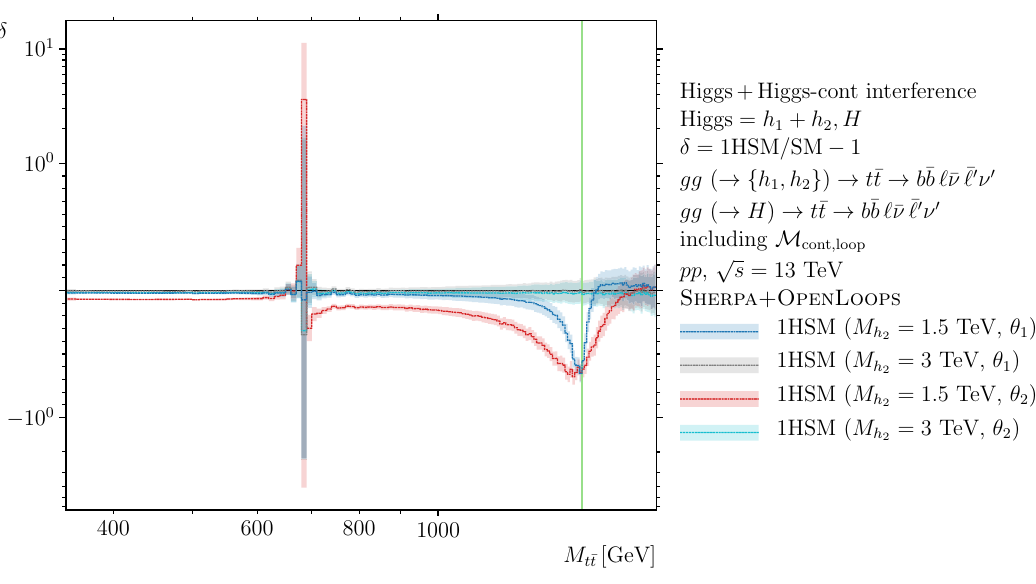
1 of the Higgs cross section including − = 1 . 5 , 3 TeV, θ 1 , θ 2 ) compared to the 2 { } { }